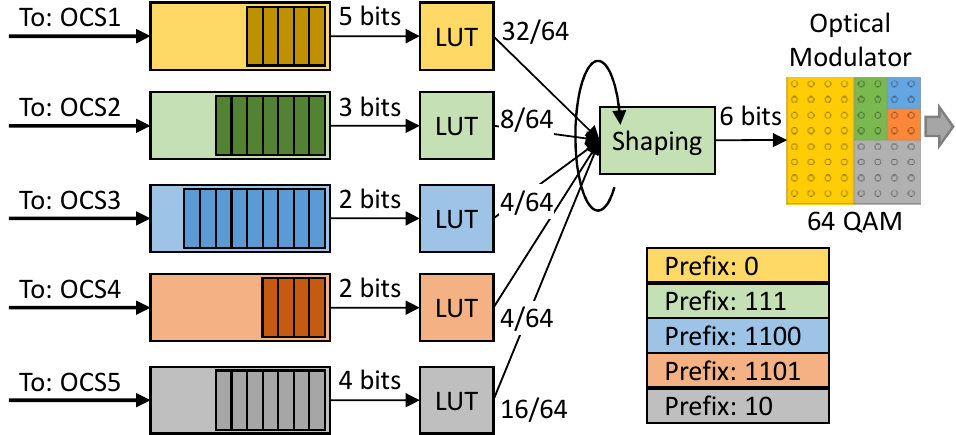
clarity, we assume m = 64 hereafter.